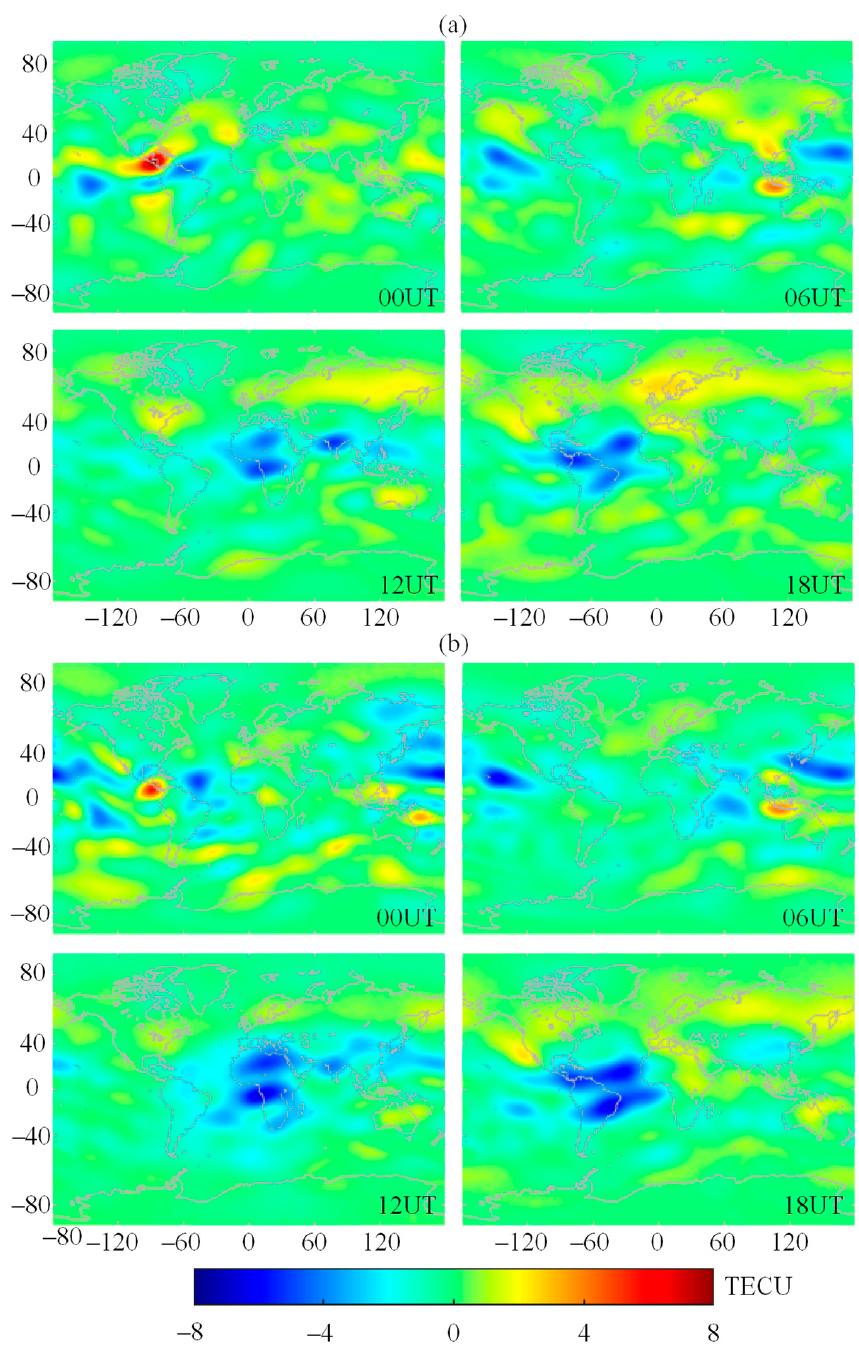
Figure 2. The difference between CODG value and the forecasted value on 1 June 2019, with a time interval of 6 h, longitude on the horizontal axis, and latitude the vertical axis. ( a ) The difference between Prophet value with CODG value. ( b ) The difference between COPG value with CODG value. Table 2. Residual percentage analysis of the Prophet model and the COPG model.